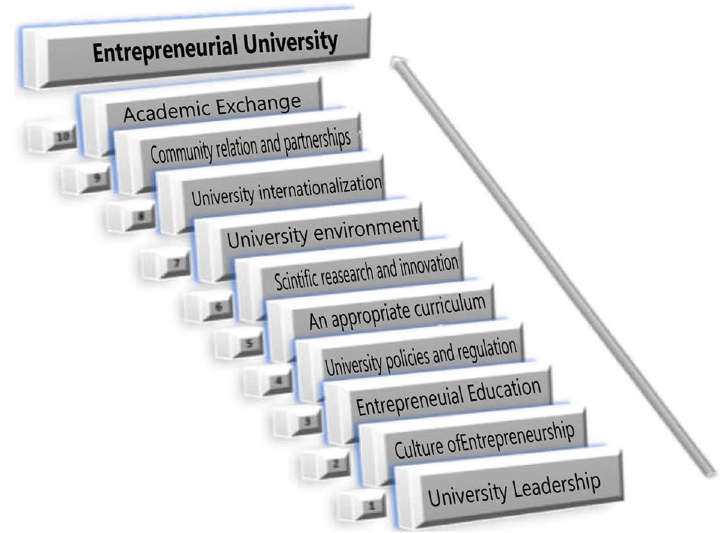
Fig. 1 Priorities of the university’s requirements required for the transition into an entrepreneurial university